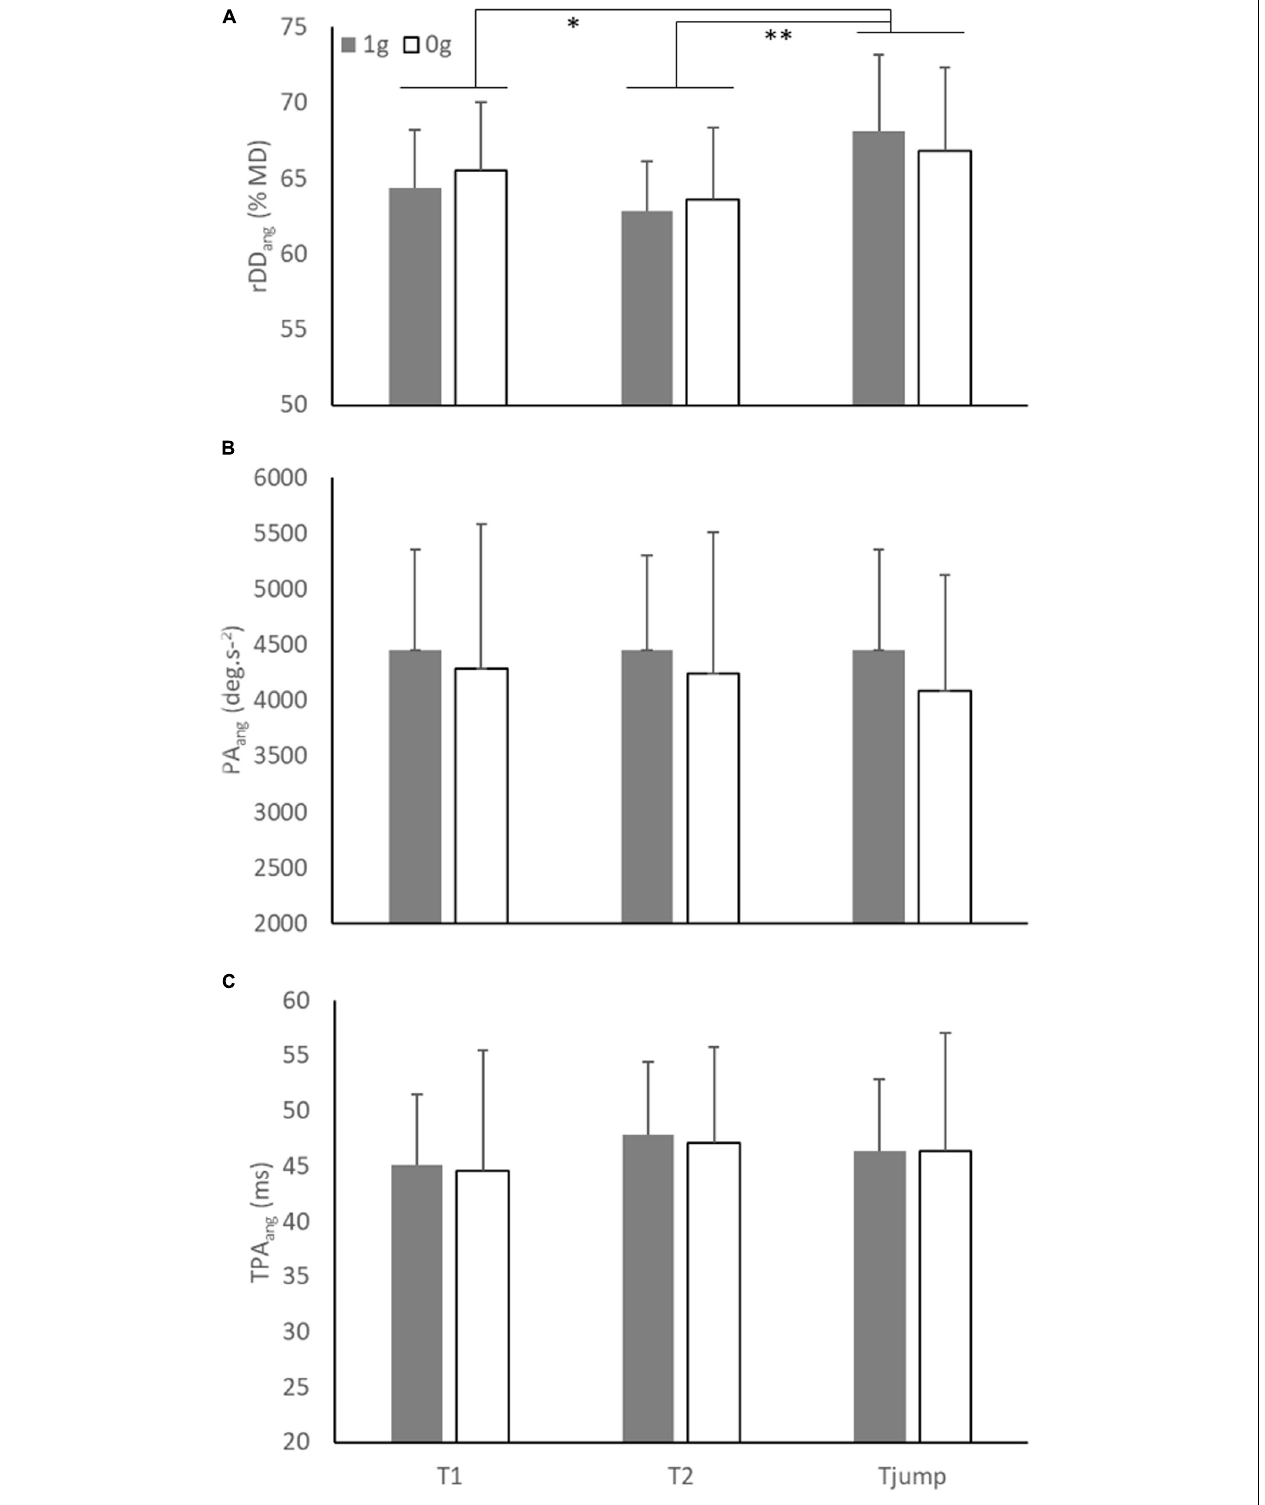
FIGURE 5 | (A) Mean relative angular deceleration duration (rDD ang ), (B) mean peak angular acceleration (PA ang ), and (C) mean time to peak angular acceleration (TPA ang ) as a function of environment and target presentation. Error bars represent 95% confidence interval. Significant differences were noted by stars (* = p < 0.05; ** = p < 0.01).